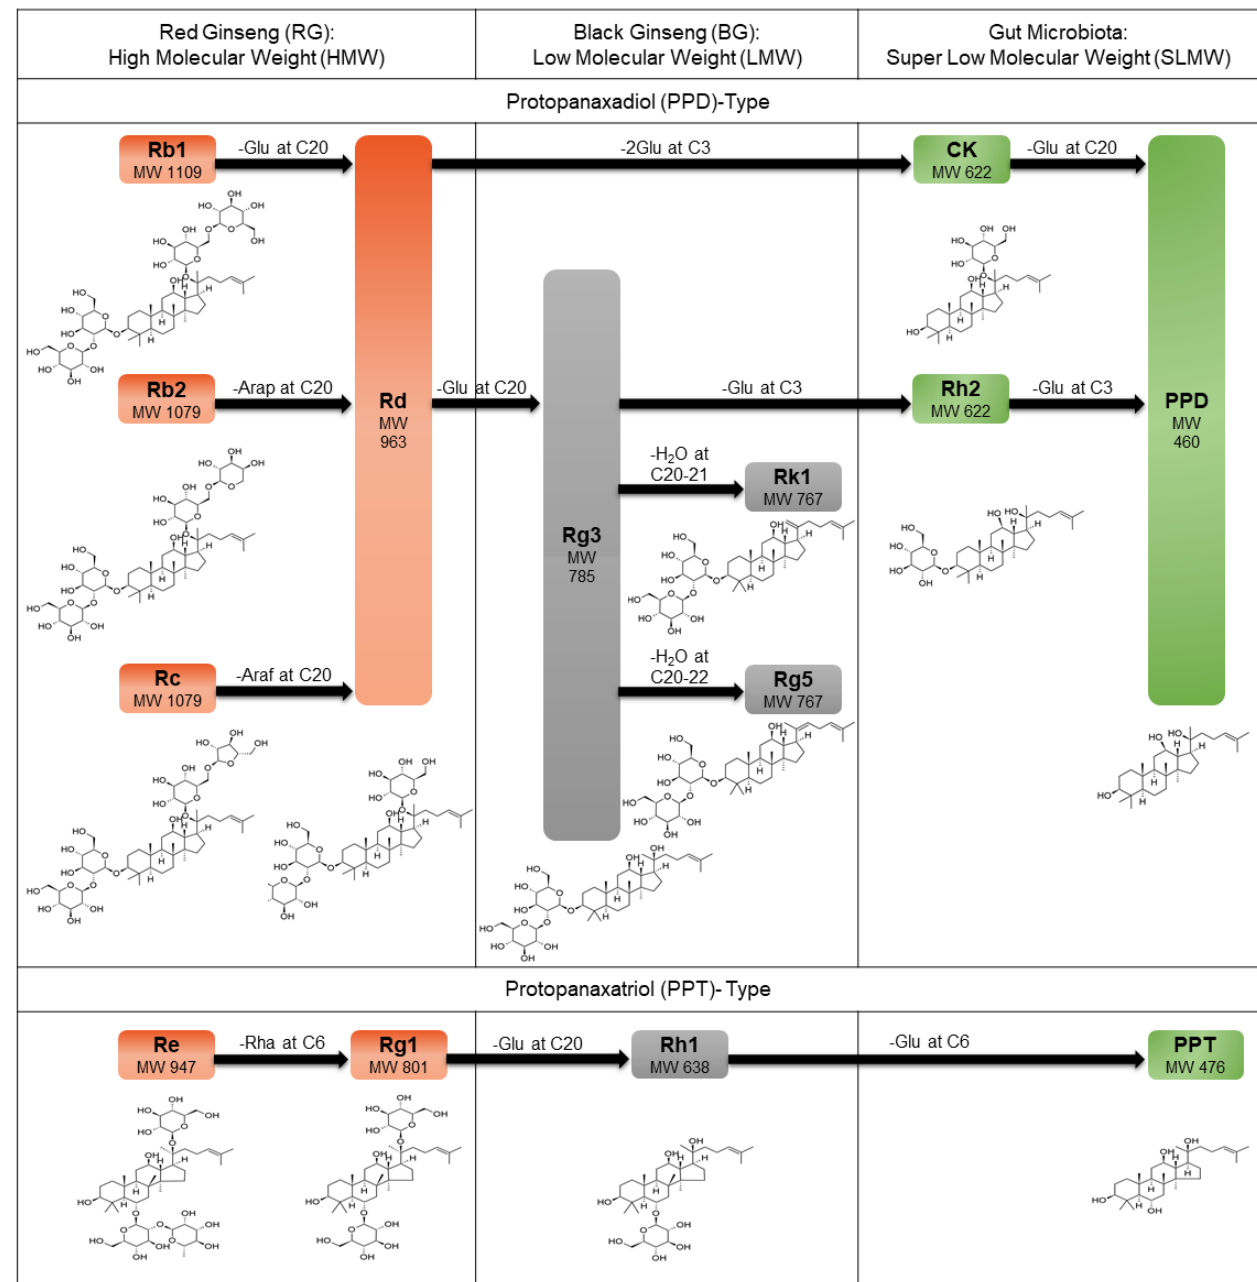
Figure 1. Multiple steaming cycles and gut microbial activity reduce the molecular weight (MW) of ginsenosides in ginseng. Ginsenosides are tetracyclic triterpene (dammarane)-type saponins and are divided into protopanaxadiol (PPD) type (e.g., Rb1, Rb2, Rc, Rd, Rg3, Rk1, Rg5, CK, Rh2, and PPD) and protopanaxatriol (PPT) type (e.g., Re, Rg1, Rh1, and PPT). Based on their size, ginsenosides are divided into three groups: (1) high molecular weight (HMW) (>800) ginsenosides found in red ginseng (RG) such as Rb1 (MW: 1109), Rb2 (MW: 1079), Rc (MW: 1079), Rd (MW: 1079), Re (MW: 947), and Rg1 (MW: 801); (2) low MW (LMW) (>637, <800) ginsenosides in black ginseng (BG) such as Rg3 (MW: 785), Rk1 (MW: 767), Rg5 (MW: 767), and Rh1 (MW: 638); and (3) super low MW (SLMW) (<623) ginsenosides such as CK (MW: 622), Rh2 (MW: 622), PPD (MW: 460), and PPT (MW: 476). In PPD type, Rb1, Rb2, Rc, and Rd are deglycosylated at C20 on dammarane to generate Rg3 using heat. Rk1, with a double bond at C20–21, and Rg5, with a double bond at C20–22, are produced from Rg3 through heat-mediated dehydration. Rd and Rg3 are further transformed into CK and Rh2, respectively, and eventually to PPD by gut flora. Re and Rg1 are PPT types, which are used to generate Rh1 by sequentially deleting rhamnose at C6 and glucose at C20. The outer glucose residue of Rh1 at C6 is removed by microbial enzymes to form PPT. Glu: glucose; Arap: arabinose (pyranose form); Araf: arabinose (furanose form); Rha: rhamnose.